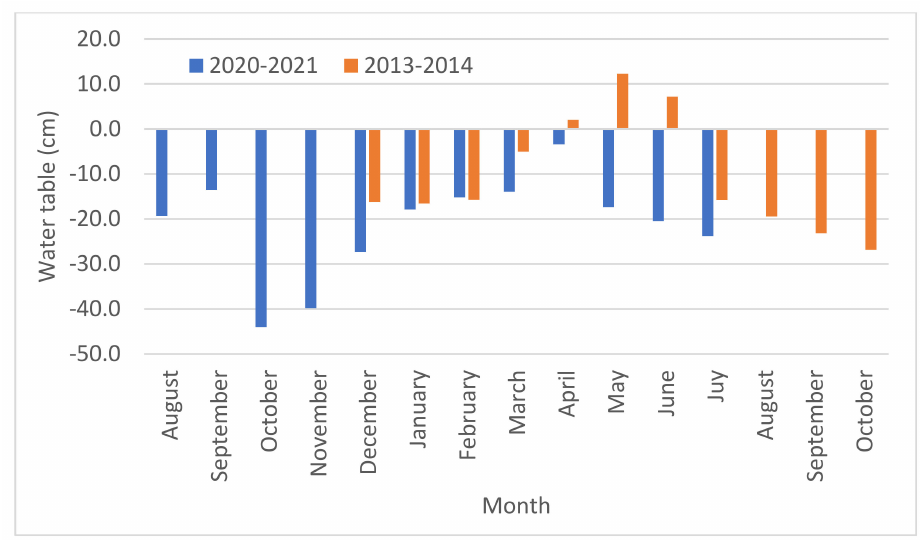
Figure 1. Water table depths measured in 2013–2014 and in